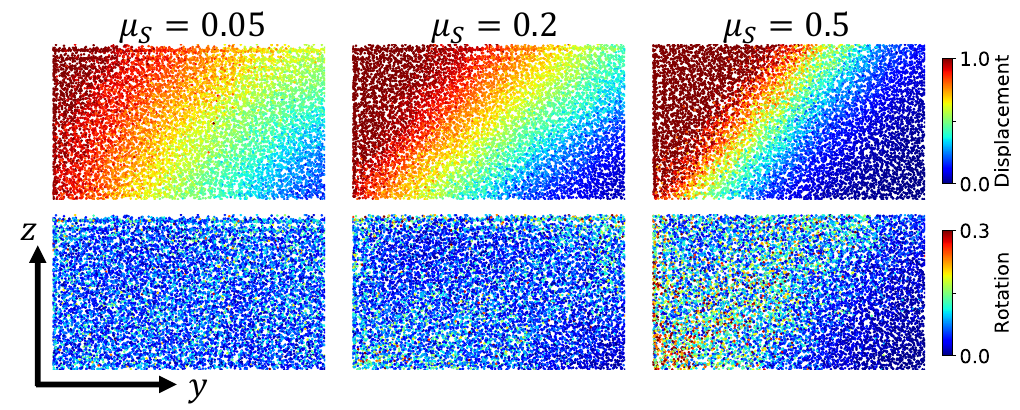
Figure 2. Two-dimensional projection of the amplitude of grain translations (top row) and rotations (bottom row) when fully com- pressed for varying friction coe ffi cients. All values here were normalized by the compression amplitude A = 0 . 15 cm. The scale for the rotations is saturated for clarity. The system is compressed from the left. A weight is free to move on the